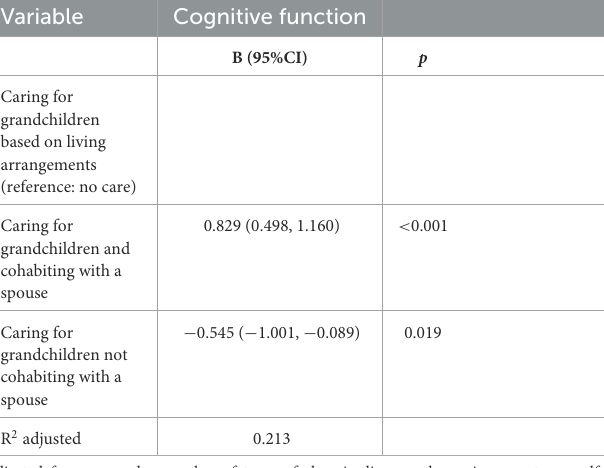
TABLE 2 Regression results of caring for grandchildren based on living arrangements and cognitive function. Variable